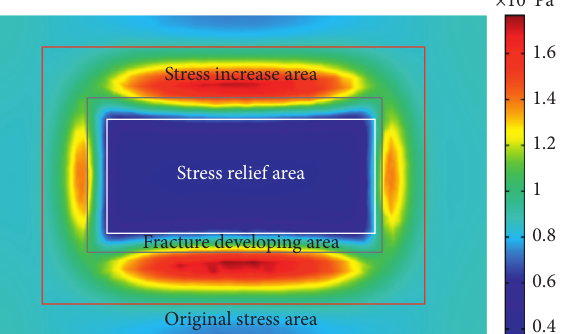
Figure 9: Stress distribution characteristics of #3 coal